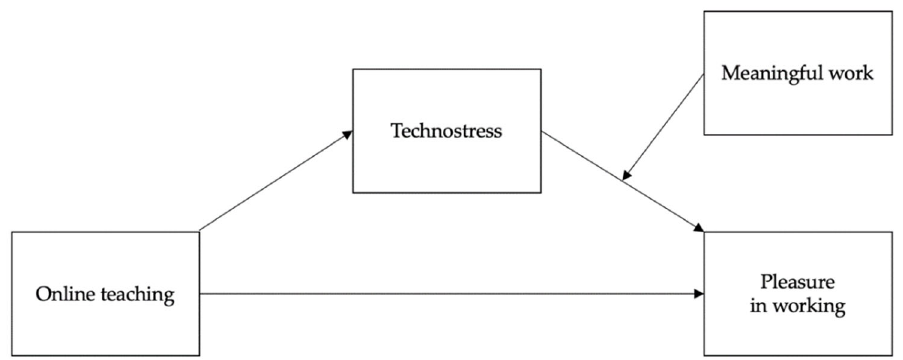
Figure 1. The hypothesized moderated mediation model.